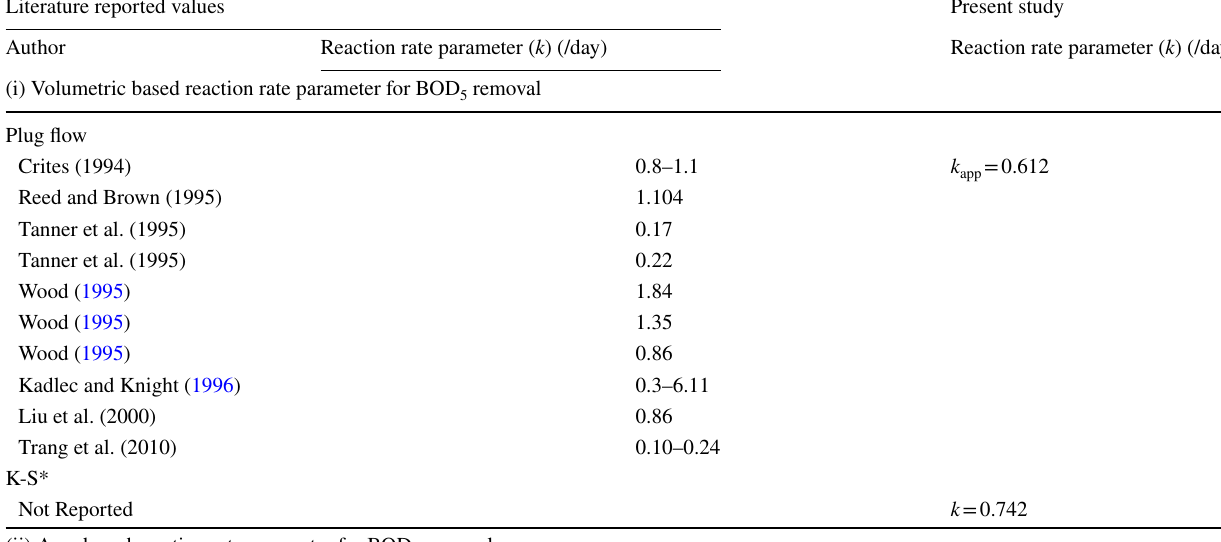
5 and TKN removal